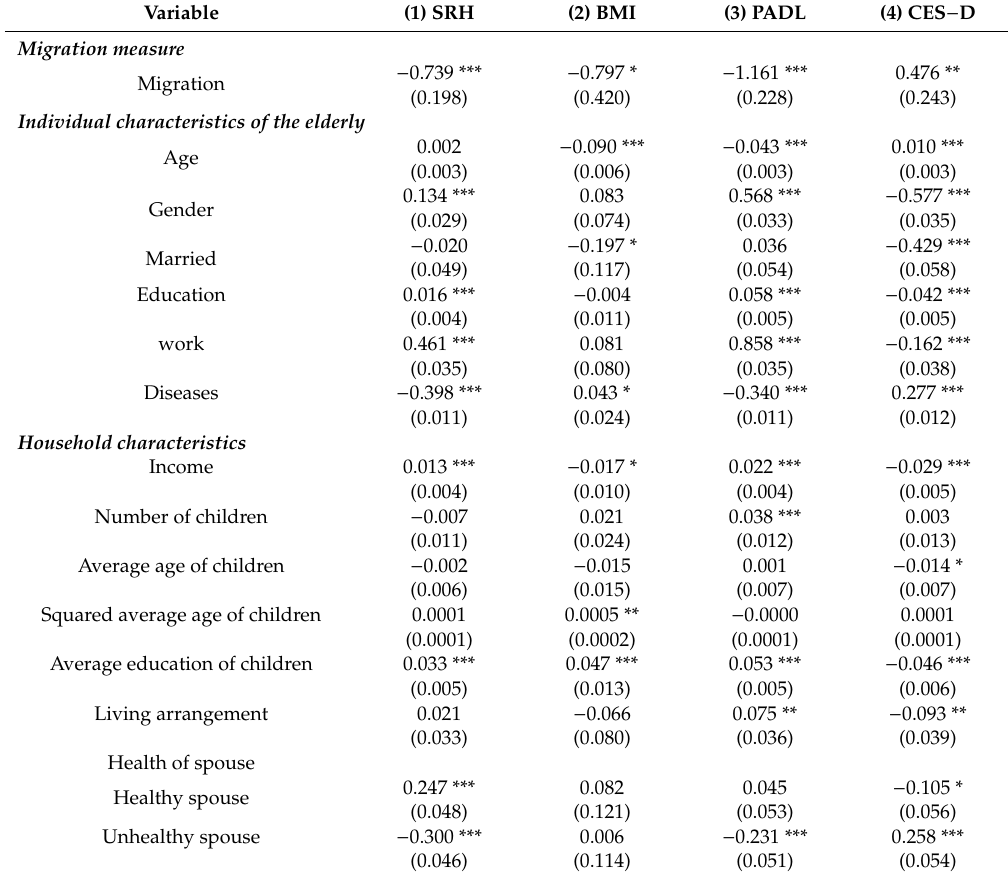
Table A1. Robustness Estimation of child migration and parental health: IV-(ordered) logistic